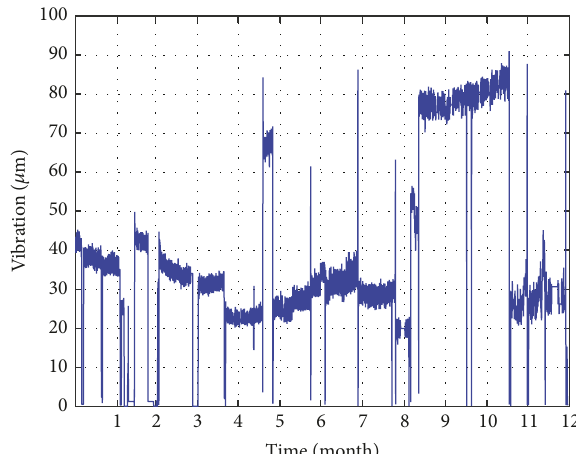
Figure 9: [CS2] IGT inlet bearing vibration information (months 1–12—all operations including